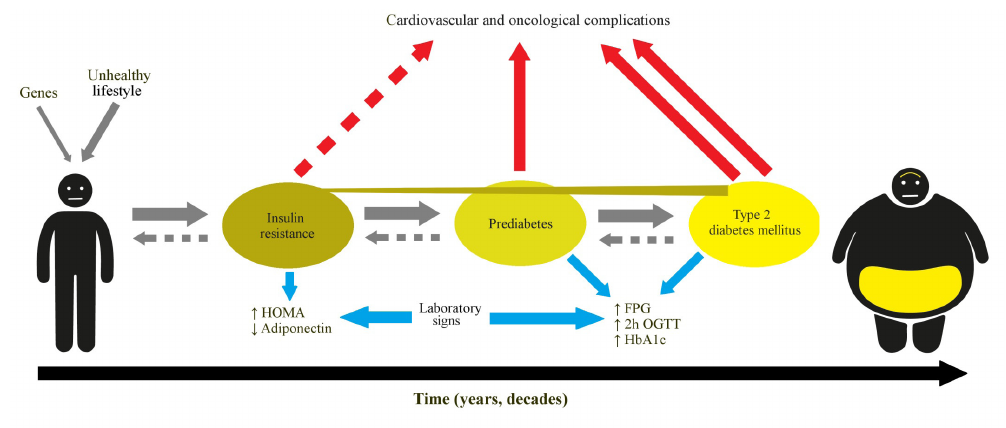
Fig. 2. Basic summary of developement of glucose metabolism disorders with their biomarkers. HOMA – homeostatic model assessment, FPG – fasting plasma glucose, OGTT – oral glucose tolerance test, HbA1c – hemoglobin